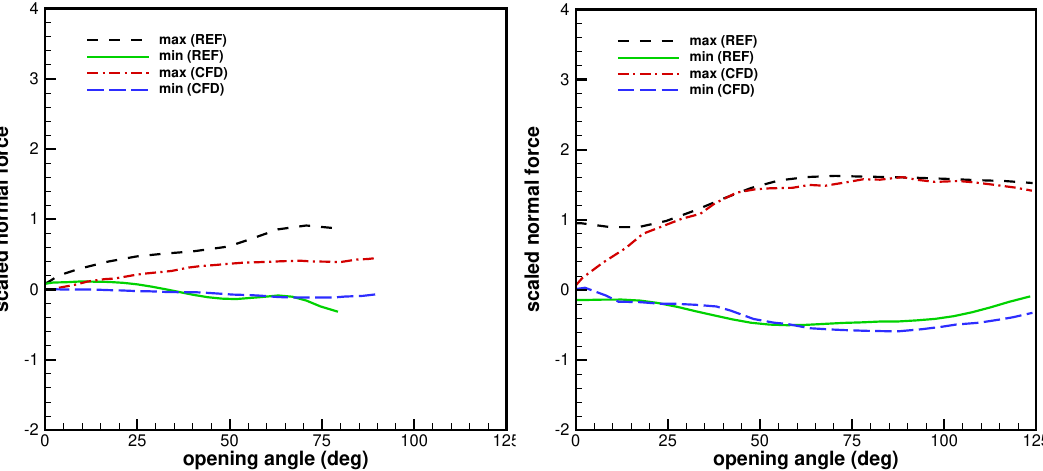
Figure 21. Extrema of the scaled normal force on the doors for (left) NLG and (right) MLG